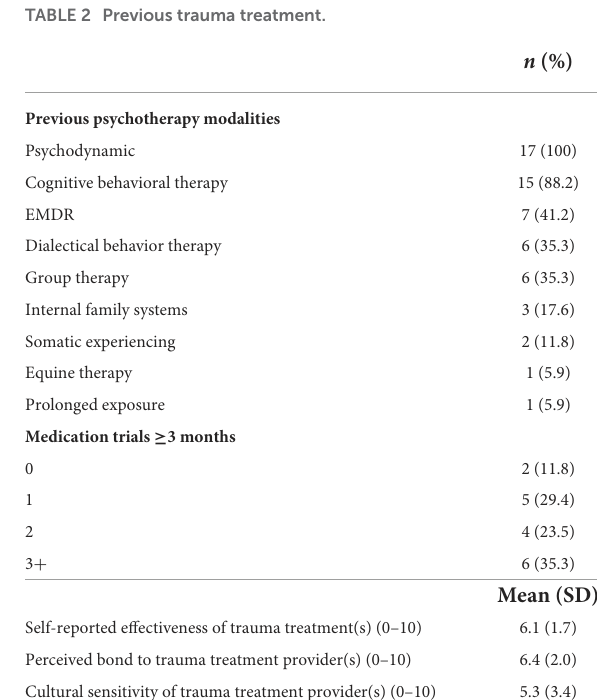
TABLE 2 Previous trauma